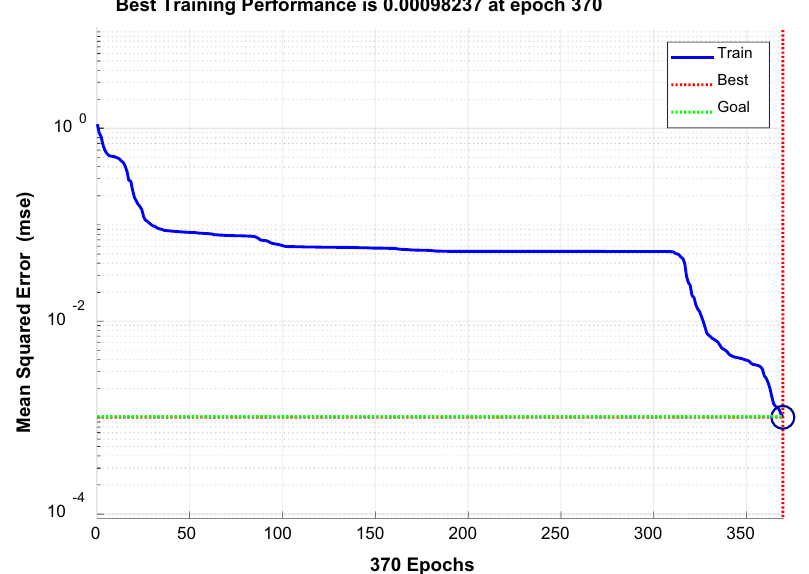
Figure 18. Trainbfg performance curve.